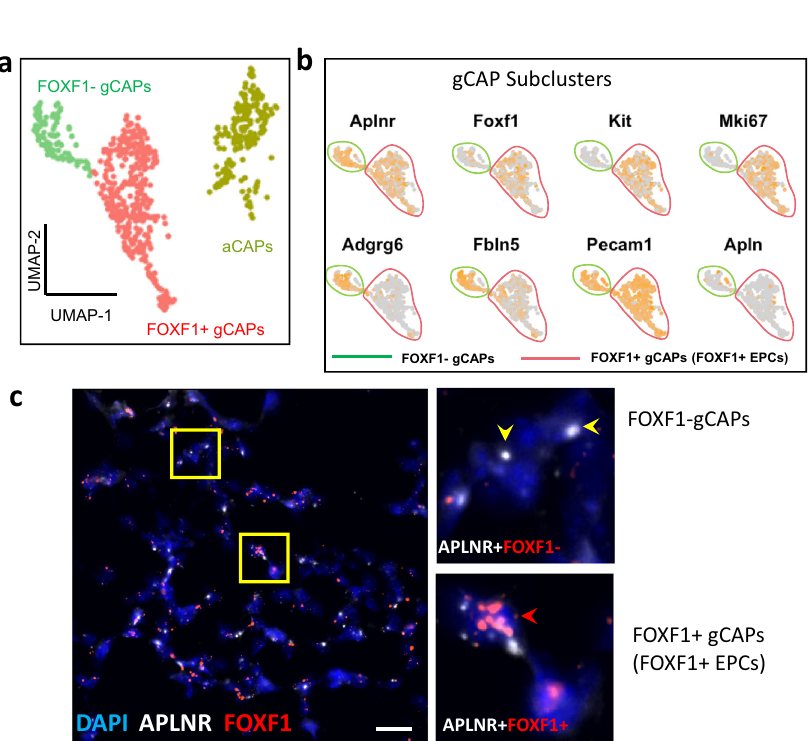
Fig. 2 Single cell RNAseq analysis reveals decreased ACVRL1 expression in gCAPs of Foxf1 WT/S52F mice. a Dimensional reduction plot with UMAP shows fi ve subclusters of pulmonary endothelial cells in E18.5 lungs. Lungs were harvested from E18.5 mouse embryos, enzymatically digested and then incubated with CD45 + immunobeads to deplete hematopoietic cells. Three embryos from each genotype were pooled together prior to the scRNAseq analysis. b Split dimensional reduction plots of pulmonary endothelial cells from WT ( n = 532 cells) and Foxf1 WT/S52F embryos ( n = 320 cells). c , d Violin and scatter plots show an enrichment of Foxf1 mRNA in pulmonary capillary cells. Foxf1 expression is selectively decreased in gCAPs but not aCAPs from Foxf1 WT/S52F embryos. T -test (two-tailed) analyses were performed, and pvalue for Foxf1 is 0.01257. * p < 0.05, p > 0.05 is ns. e Heatmap shows representative gCAP genes, expression of which is decreased in Foxf1 WT/S52F embryos compared to WT embryos. f Analysis of signaling pathways demonstrates that gCAPs of Foxf1 WT/S52F embryos exhibit decreased expression of genes associated with the TGF β /BMP signaling pathway, sphingolipid metabolism, endocytosis, Rap1 and PPAR pathways. Fisher ’ s Exact (one-sided) test was used via DAVID bioinformatic resource to measure gene- enrichment p -values. g Violin plots show decreased expression of Acvrl1 in gCAPs but not aCAPs. Expression of Bmpr2 and Eng is unchanged T -test (two- tailed) analyses were performed, and p-value for Acvrl1 is 0.01993. p < 0.05 is * p > 0.05 is ns. h , i Violin plots show decreased expression of downstream target genes of the TGF β /BMP signaling pathway in pulmonary gCAPs, including Tmem100, Calcrl, Clec14a , Id1 and Id3 . T -test (two-tailed) analyses were performed, and pvalue for Tmem100 is 0.01688, for Calcrl is 0.02132, for Clec14a is 0.0213, for Id1 is 0.03623, for Id3 is 0.037811. * p < 0.05, p > 0.05 is ns. The data for box plots in d and g – i were retrieved from single cell normalized counts (WT: n = 532; Foxf1 WT/S52F : n = 320) Boxplots: center line, median; box boundary, fi rst and third quartiles; whiskers denote 5th – 95th percentile. Expression of these genes in pulmonary aCAPs was unchanged. ns is not